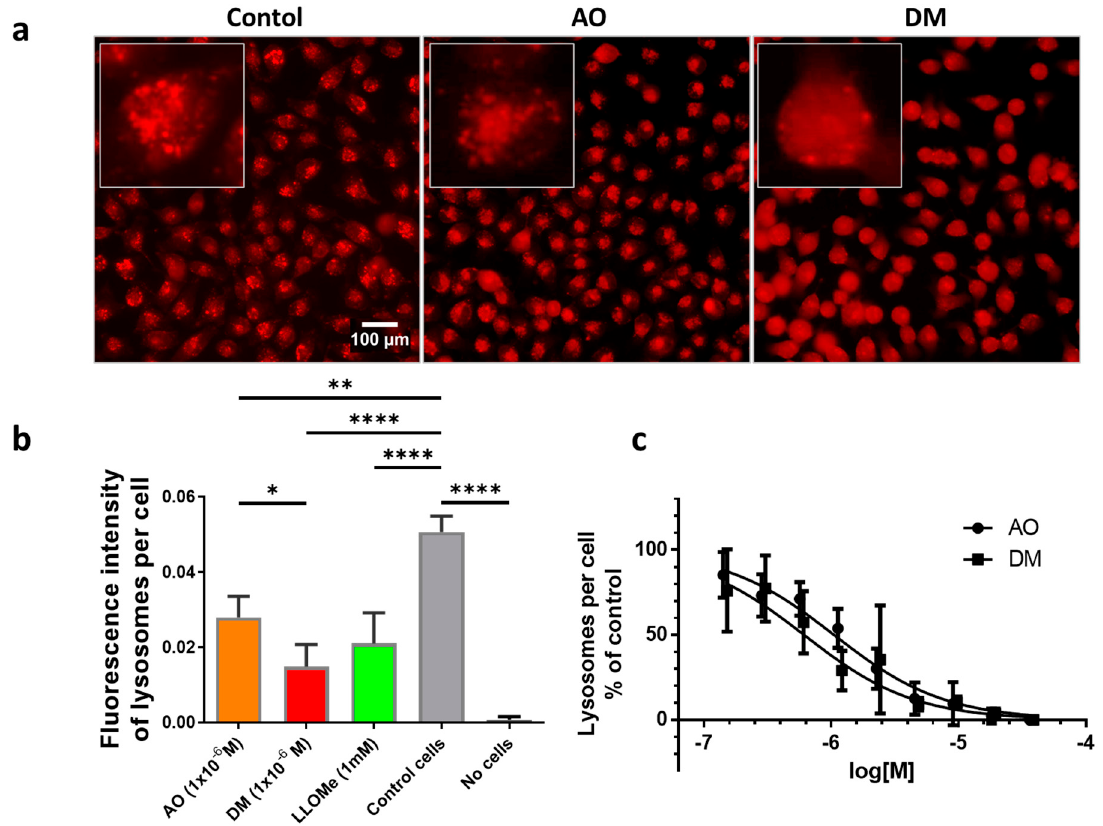
Figure 8. DM causes more significant photodynamic lysosomal damage than AO. The integrity of the lysosomes was examined with LysoOrange dye in HeLa cells. Panel ( a ): Under control conditions (leftmost image), LysoOrange stains many lysosomes around the nucleus with high intensity and contrast, while the cytoplasmic background intensity is low. With blue light illumination after AO and DM pretreatment, fewer lysosomes are stained with the LysoOrange. However, DM has a higher cytoplasmic background intensity (rightmost image) than AO (middle image). In each of the overview images having a low magnification, a representative cell of the sample can be seen magnified. The inserts represent 80 · 80 µ m 2 in size. Panel ( b ): Image analysis was applied to determine the average fluorescence intensity of the LysoOrange dye in single cells. This average is proportional to the lysosome content of cells. During the DM treatment, significantly fewer intact lysosomes remained in the cells than during AO treatment ( p = 0.02). LLOMe, a known photodynamic lysosomal damaging compound, was used as the positive control. Panel ( c ): The photodynamic dose-response curves of AO and DM were determined by image analysis of the lysosome integrity. The half-effective dose was 1.1 µ M for AO, while 0.6 µ M for DM. The statistical comparison of fits indicated a significant difference ( p = 0.0003) between curves; (*: p < 0.05, **: p < 0.01, ****: p < 0.001). One representative data set out of three experiments is displayed. Details of the image analysis can be found in the supplementary